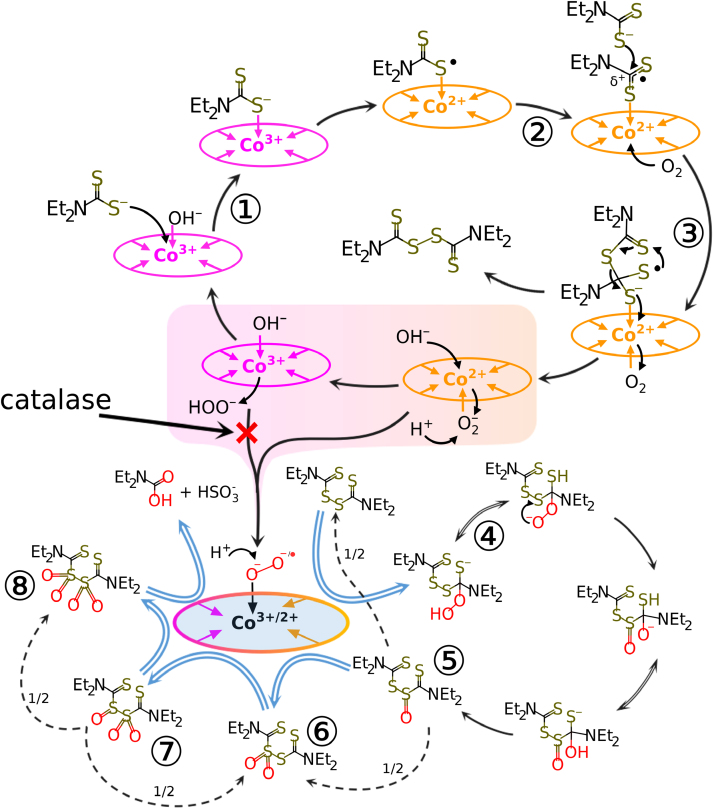
A scheme of the oxidation of DDC in the presence of HOCbl. The major transformations are denoted by a black solid line arrows; the disproportionation of unstable oxidized derivatives of DSF is shown by a black dashed line arrows; oxidation of DSF and its oxidized products, catalyzed by a complex Cbl–(HO2-/O22-), is shown by a blue line double arrows; ①, ②, ③ – the stage of DDC oxidation; ② - the stage that is sensitive to thiols present in the system. ④ – A hypothetical mechanism of the oxidation DSF derivatives by the action of a cobalamin–hydroperoxide/superoxide anion complex; Left Right Double Arrows denote the reversible stage of the reaction, and blue double arrows denote the irreversible stage of the reaction; ⑤, ⑥, ⑦, ⑧ – the structures of oxidized DSF derivatives.